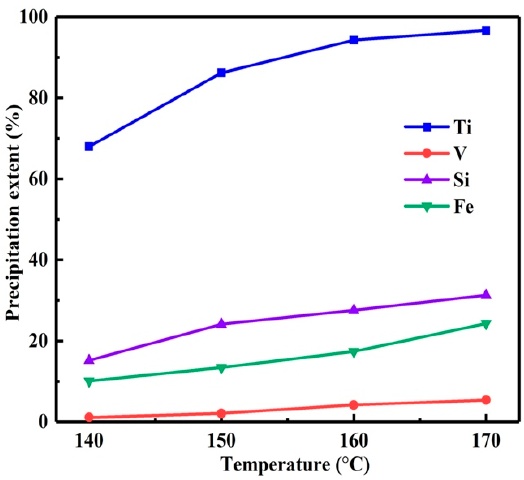
Figure 2. Influence of reaction temperature on precipitation extents.